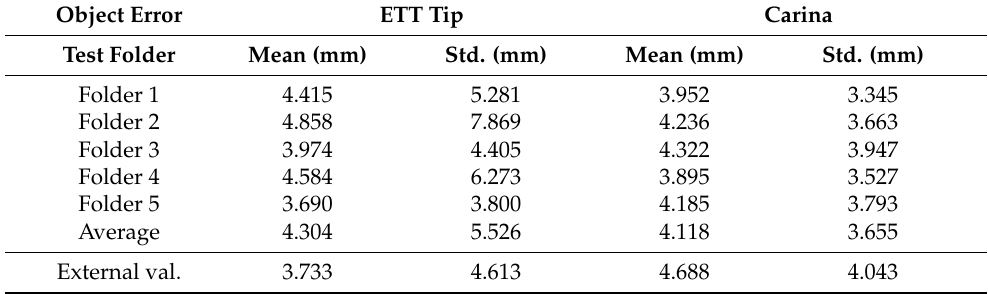
Table 6. The performance in object